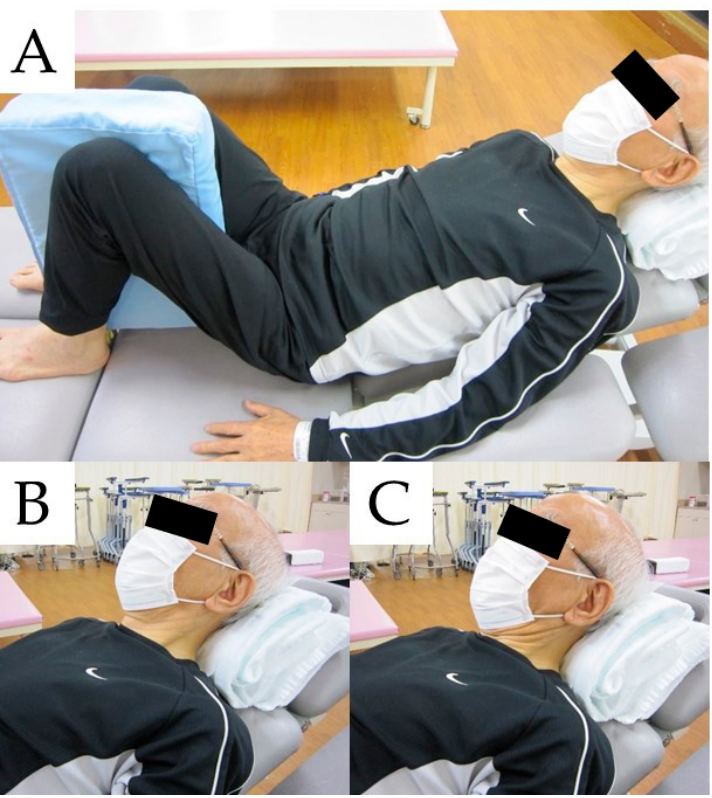
Figure 2. Posture during exercises. ( A ) Training posture, ( B , C ) deep cervical flexor muscle